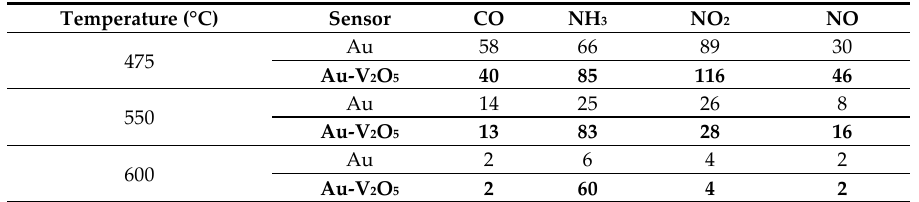
Figure 3. Response of the ( a ) Ni 3 V 2 O 8 sensors at 700 °C and ( b ) Au-V2O5 sensors at 600 °C for pulses of CO (100 ppm), NH 3 (20 ppm), NO 2 (100 ppm) and NO (100 ppm) in base gas. Table 1. Comparison of Au and Au-V 2 O 5 sensor responses ( ∆ V in mV) at different temperatures to pulses of CO (100 ppm), NH 3 (20 ppm), NO 2 (100 ppm) and NO (100 ppm) in base gas ( ∆ V experimental uncertainties around 5